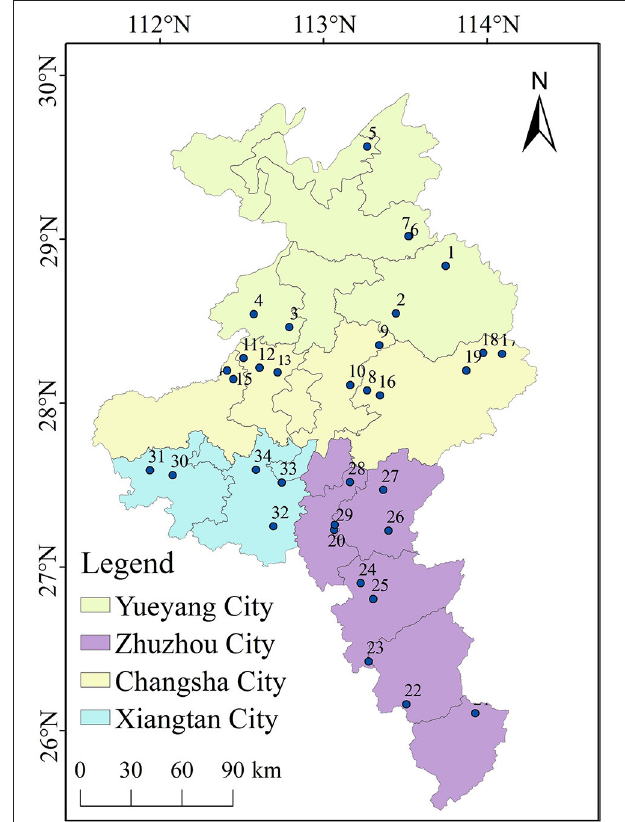
FIGURE 1 | Schematic diagram of the spatial distribution of sampling